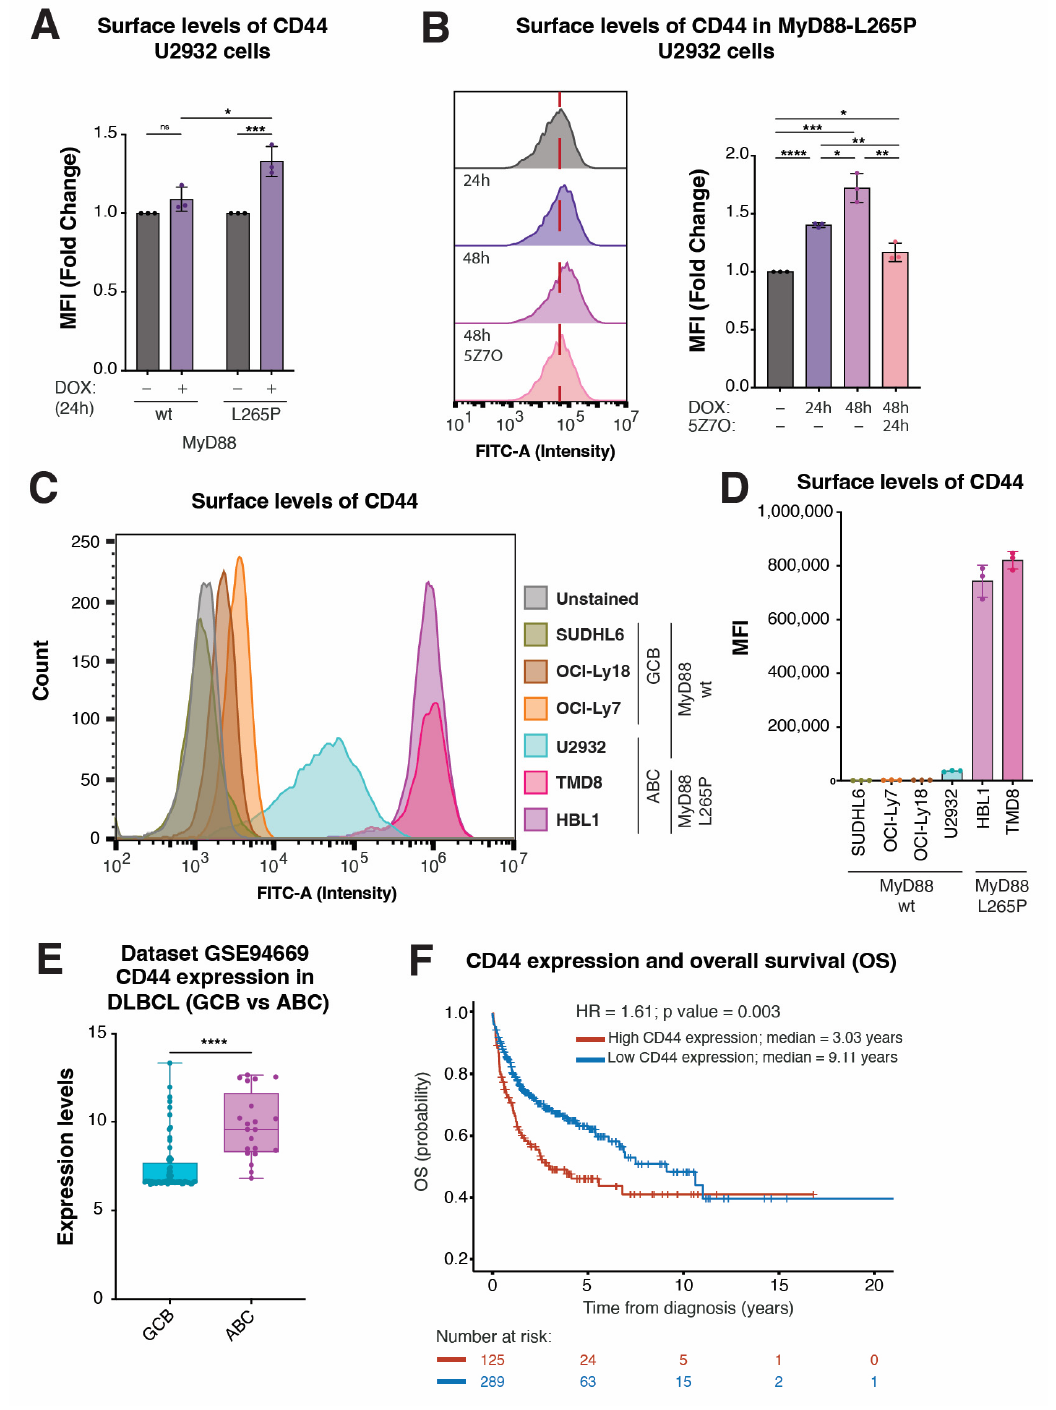
Figure 5. CD44 levels are correlated with MyD88 L265P expression and predict OS in DLBCL patients. ( A ) Mean fluorescence intensity (MFI) of CD44 ‐ FITC staining obtained with flow cytometry analysis of U2932 cell lines upon MyD88 (wt/L265P) inducible expression after 24 h of DOX treatment. ( B ) Histogram and related MFI of FITC obtained with flow cytometry analysis of U2932 cell lines upon MyD88 (wt/L265P) inducible expression after DOX and subsequent 5Z7O (1 μ M) treatments for the time intervals annotated in the figure. ( C ) Histogram showing the difference in CD44 surface levels, analyzed with surface staining and flow cytometry in SUDHL6, OCI ‐ Ly18, and OCI ‐ Ly7 cell lines (which represent GCB DLBCL with wt MyD88). The U2932 cell line represents ABC ‐ DLBCL with wt MyD88. HBL1 and TMD8 represent ABC DLBCL with MyD88 L265P . ( D ) Flow cytometry analysis of SUDHL6, OCI ‐ Ly18, OCI ‐ Ly7, U2932, HBL1, and TMD8 cell lines stained with CD44 ‐ FITC ‐ conjugated antibody shown as MFI. ( E ) Validation of CD44 expression levels in the subgroups of GCB and ABCL DLBCL cell lines from the GSE94669 dataset. ( F ) Kaplan– Meier curves for OS in DLBCL patients using the transcriptome profiling and clinical information of 449 DLBCL patients from GEO dataset (GSE10846; n = 420). The average expression of 13 CD44 probes for each patient was used for overall representation of clinical data. The patients were